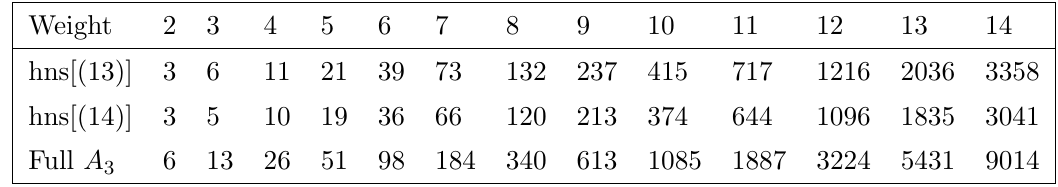
Table 1. Dimensions of the spaces of integrable words in the hexagon alphabet with hexagon initial entries f u; v; w g only and (cid:12)nal entries drawn from the neighbour sets hns[(13)], hns[(14)] or from the full nine-letter A 3